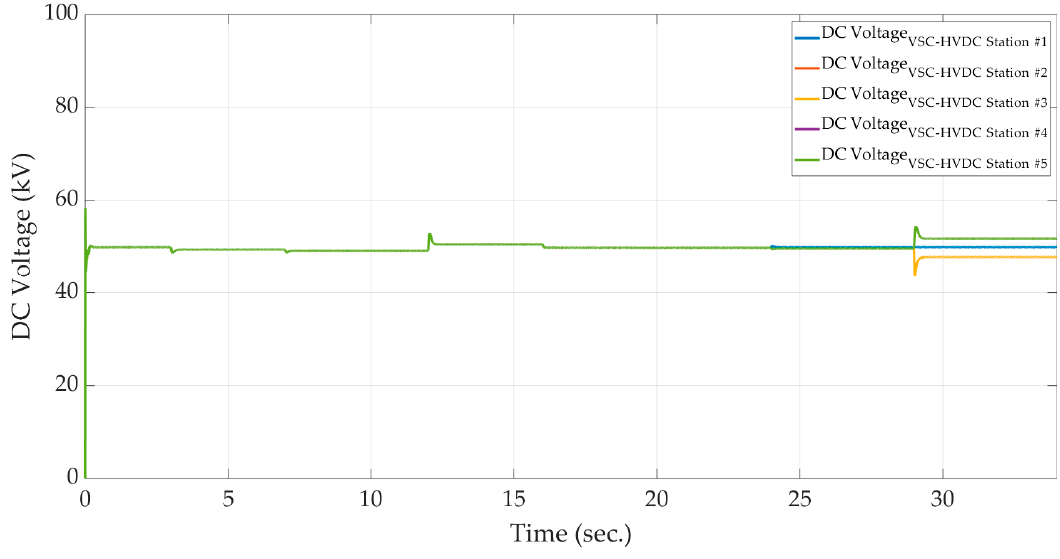
Figure 17. The DC voltage profile of different VSC-HVDC stations in the second scenario.